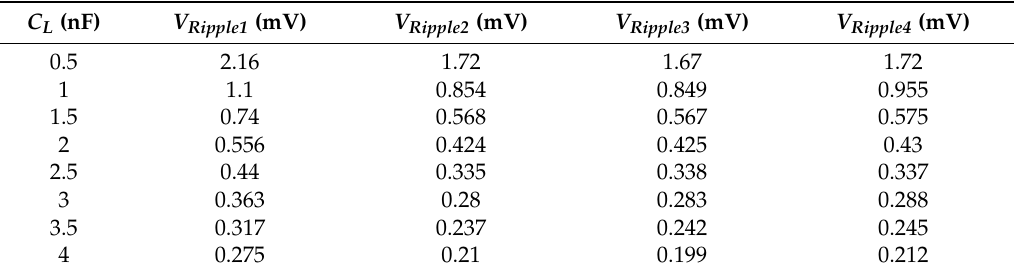
Table 1. Output capacitor size versus output voltage ripple for 4-bit SSC-DVS